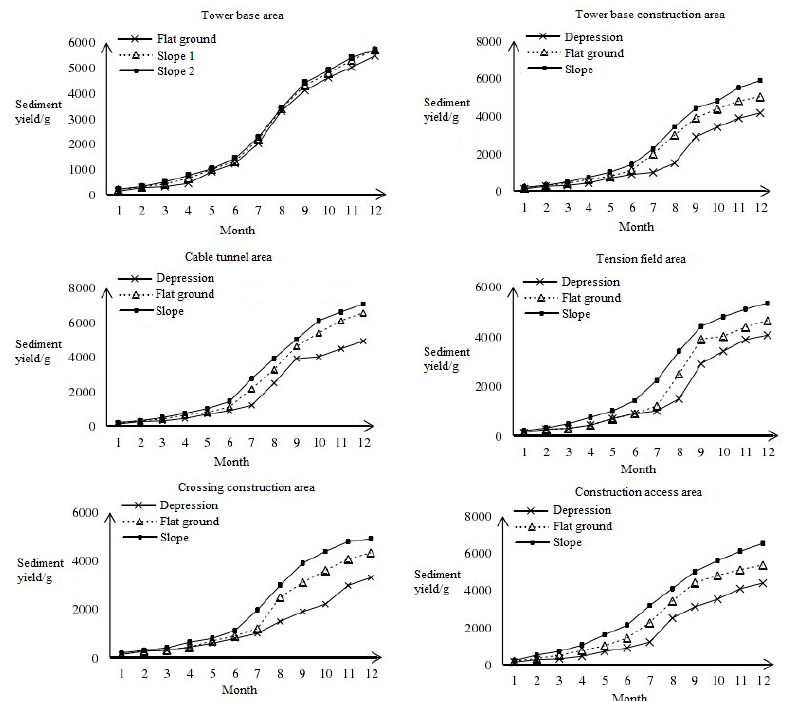
Figure 13. Cumulative sediment yield of each month after a disturbance in each division [50].